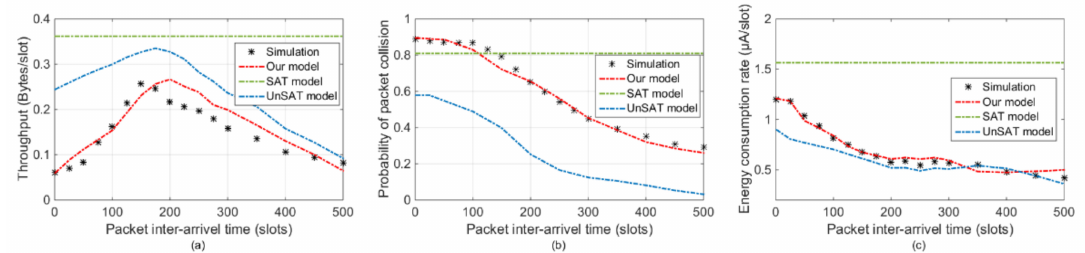
Figure 6. Overall statistics comparisons. ( a ) Aggregate throughput S . ( b ) Packet collision probability P colli .( c ) Energy consumption e